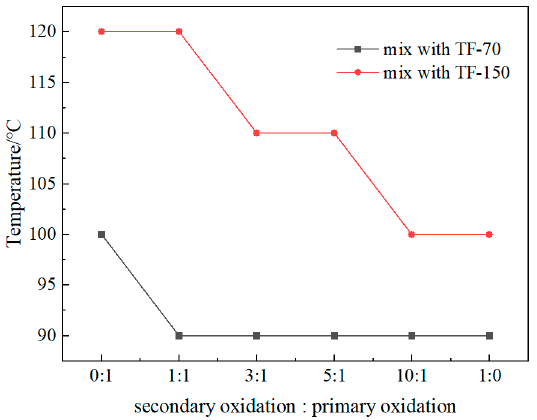
Figure 8. The temperature at which the extreme value of the alkane ratio appears.